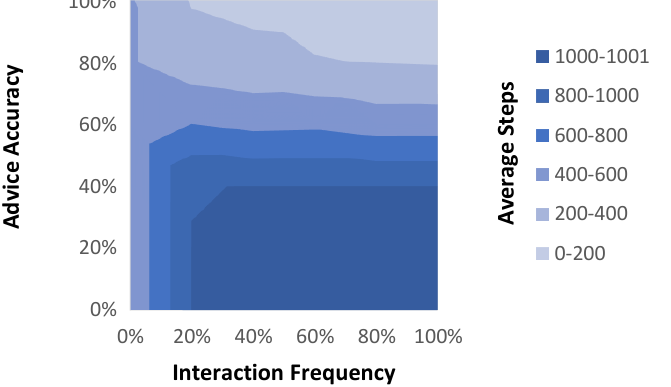
Figure 6. Impact of accuracy and availability on the agent performance. The interactive